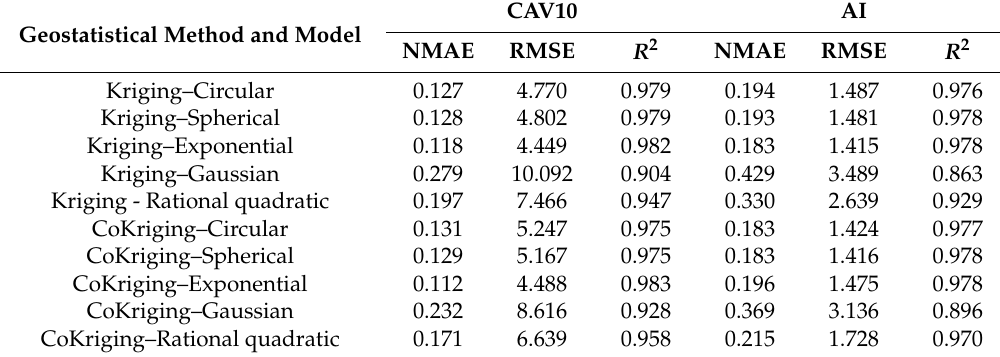
Geostatistical Method and